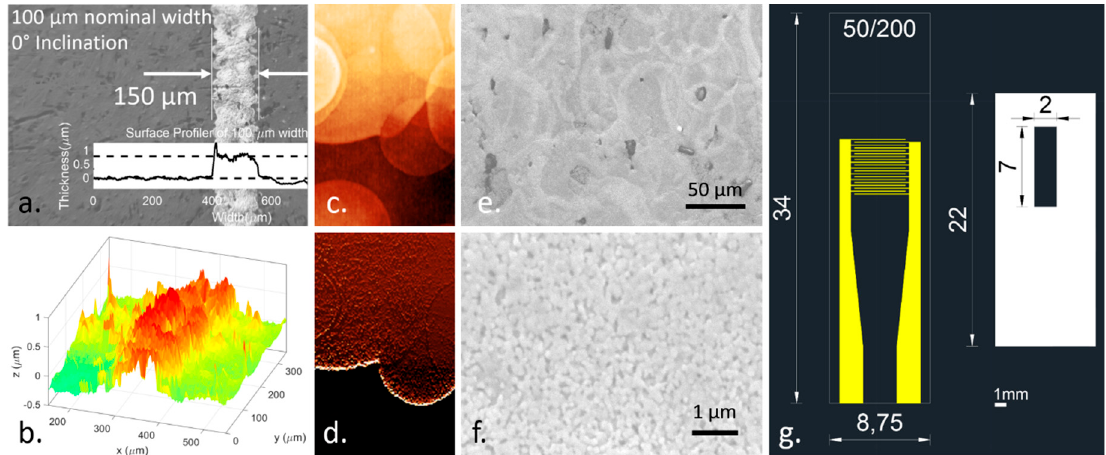
Figure 5. Images of the 100 µ m wide printed lines collected by ( a ) optical microscopy; ( b ) profilometry; ( c ) atomic force microscopy at the line edge; ( d ) conductive atomic force microscopy at the same location; ( e , f ) scan electron microscopy. ( g ) Layout of the electrodes and of the vinyl adhesive patch for the inkjet-printed IDE devices.